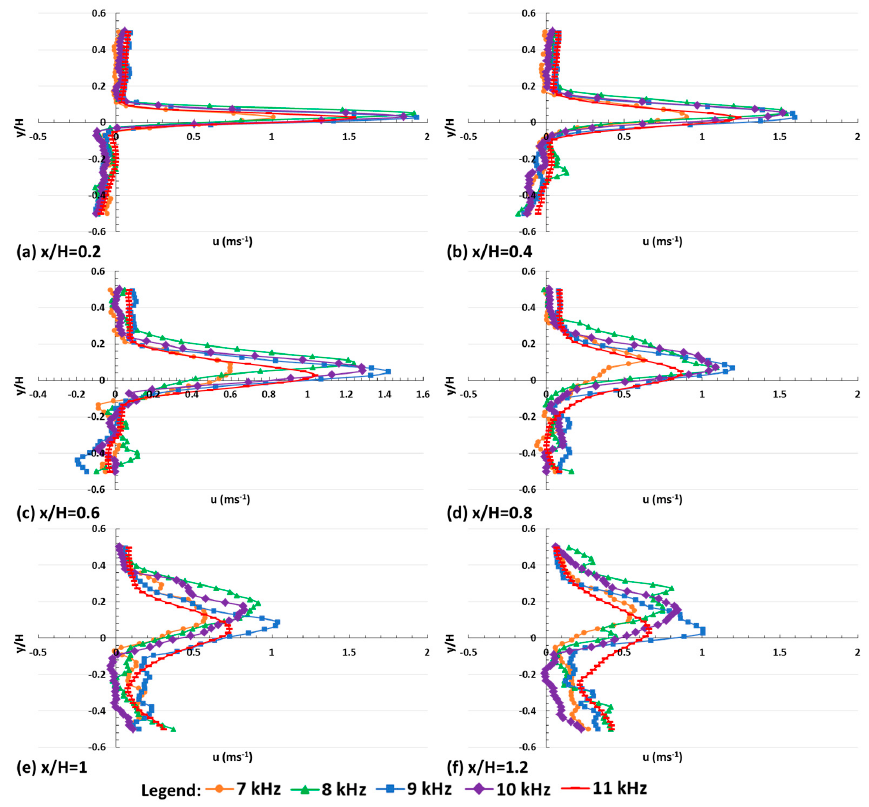
Figure 7. Jet x-velocity at various actuation frequencies at different normalised x-locations downstream of the trailer rear end. x/H = ( a ) 0.2, ( b ) 0.4, ( c ) 0.6, ( d ) 0.8, ( e ) 1.0 and ( f ) 1.2.